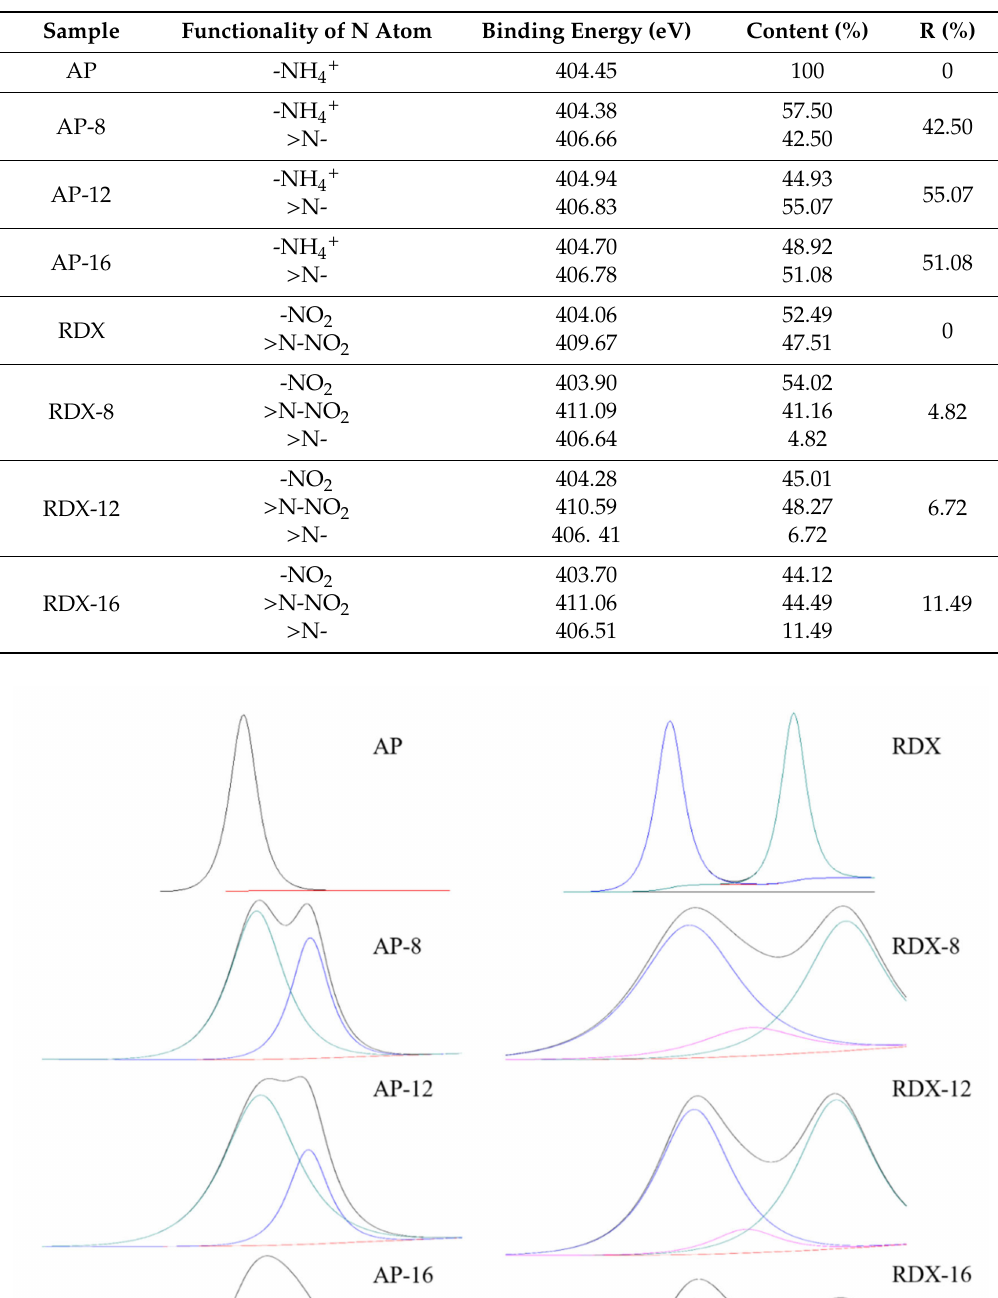
Table 1. Specifications and contents of sample N1s spectra.